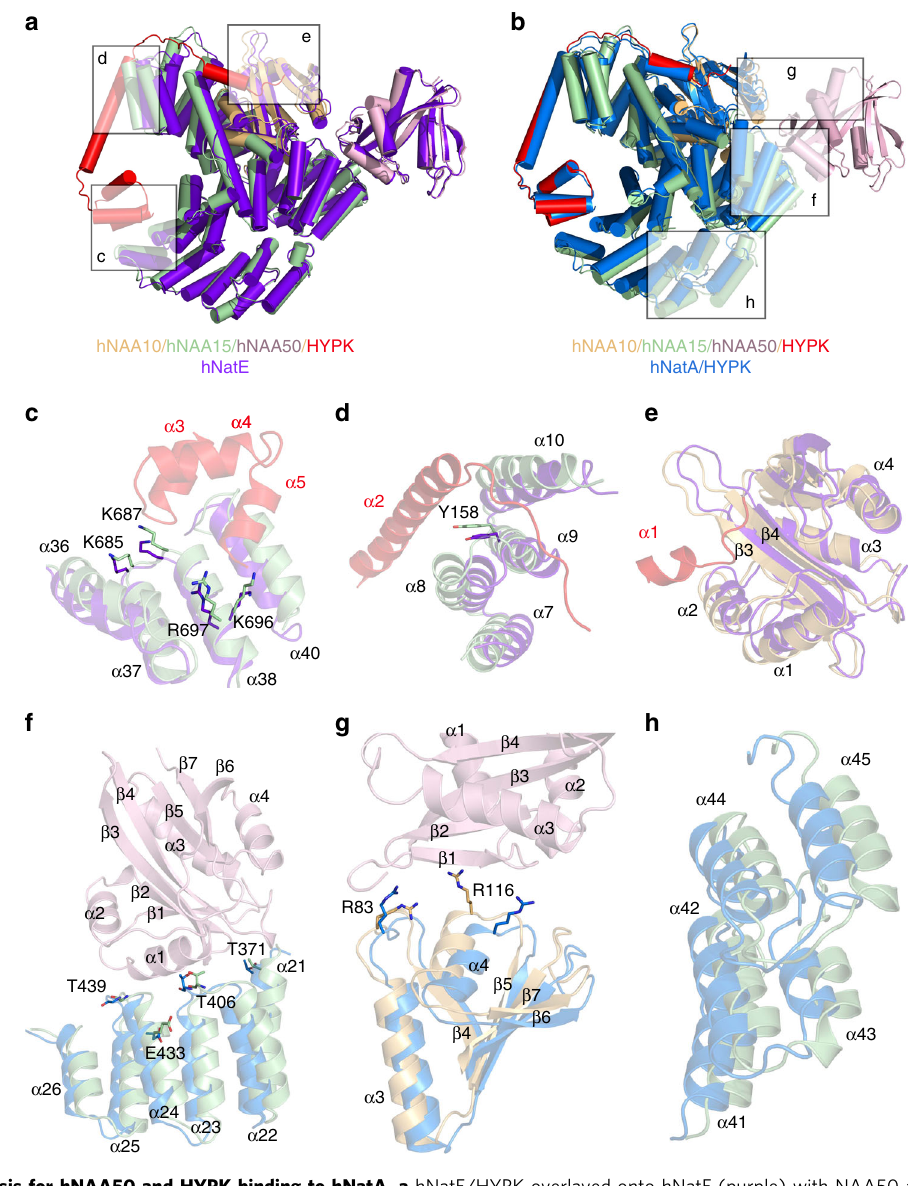
Fig. 7 Molecular basis for hNAA50 and HYPK binding to hNatA. a hNatE/HYPK overlayed onto hNatE (purple) with NAA50 aligned. b hNatE/HYPK overlayed onto hNatA/HYPK (PDB: 6C95, blue) with HYPK aligned. c Zoom-in view of HYPK C-terminal binding region as indicated in a . d Zoom-in view of HYPK α 2 binding region as indicated in a . e Zoom-in view of HYPK N-terminal α 1 domain binding region as indicated in a . f Zoom-in view shows the hNAA50 binding region on hNAA15 as indicated in b . g Zoom-in view shows the hNAA50 binding region on hNAA10 as indicated in b . h Zoom-in view shows the hNAA15 C-terminal helices conformal changes when HYPK bound as indicated in b